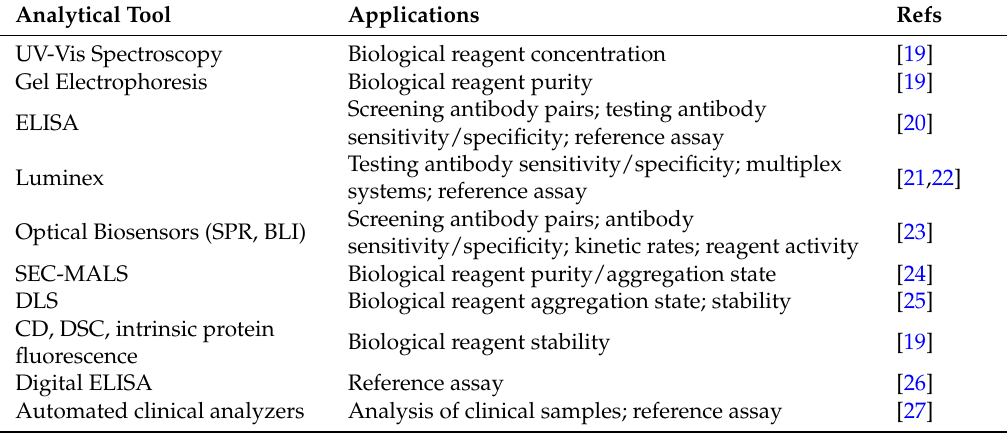
Table 1. Analytical tools for the characterization of biological reagents. SPR, surface plasmon resonance; BLI, bio-layer interferometry; SEC-MALS, size-exclusion chromatography-multiangle light